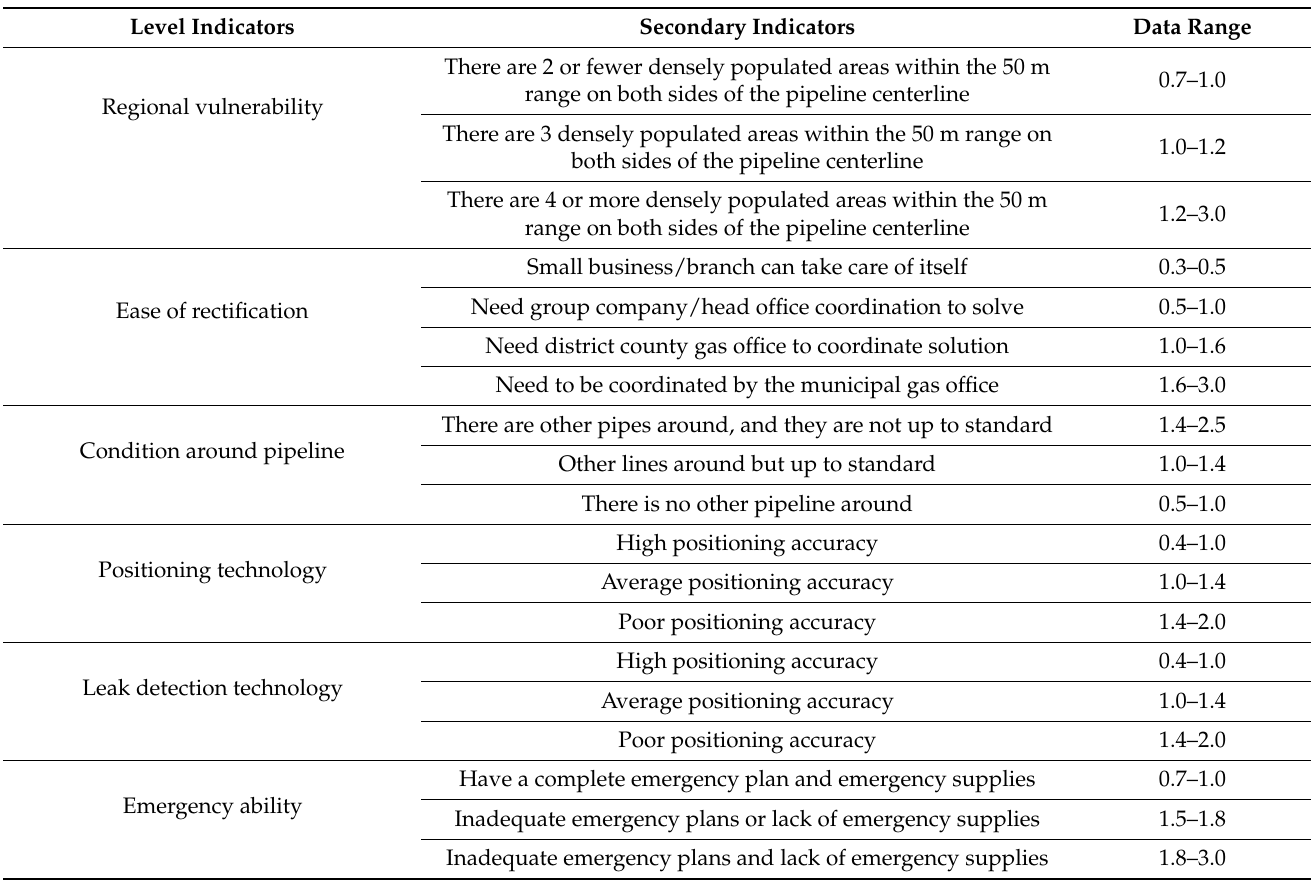
Table 10. Compensation factor values for each